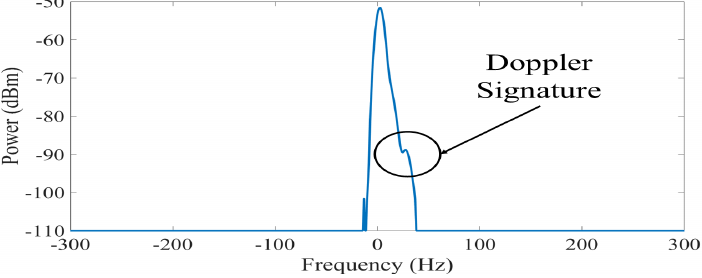
Figure 5. Probe signal pre-processed with denoising